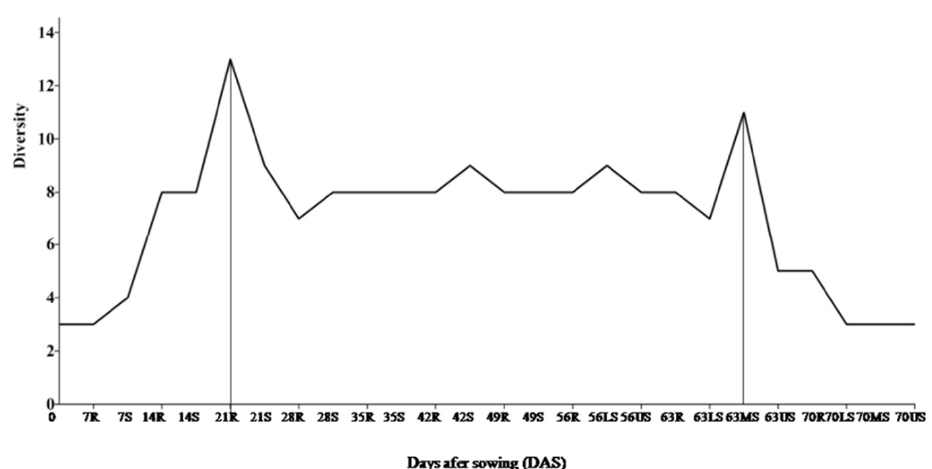
Figure 4. Change in diversity of diazotrophic endophytic bacteria with growth of pearl millet plants grown under field conditions. Highest peaks at 21R and 63MS refer to maximum diversity in roots sampled at 21 DAS and middle parts of shoots sampled at 63 DAS respectively. Letters R, S, MS, US, LS denote roots, shoot, middle shoot, upper shoot and lower shoot, respectively. Table 1. Changes in diversity of total diazotrophic endophytic population with the growth of pearl millet under field conditions. R and S represent root and shoot, respectively.